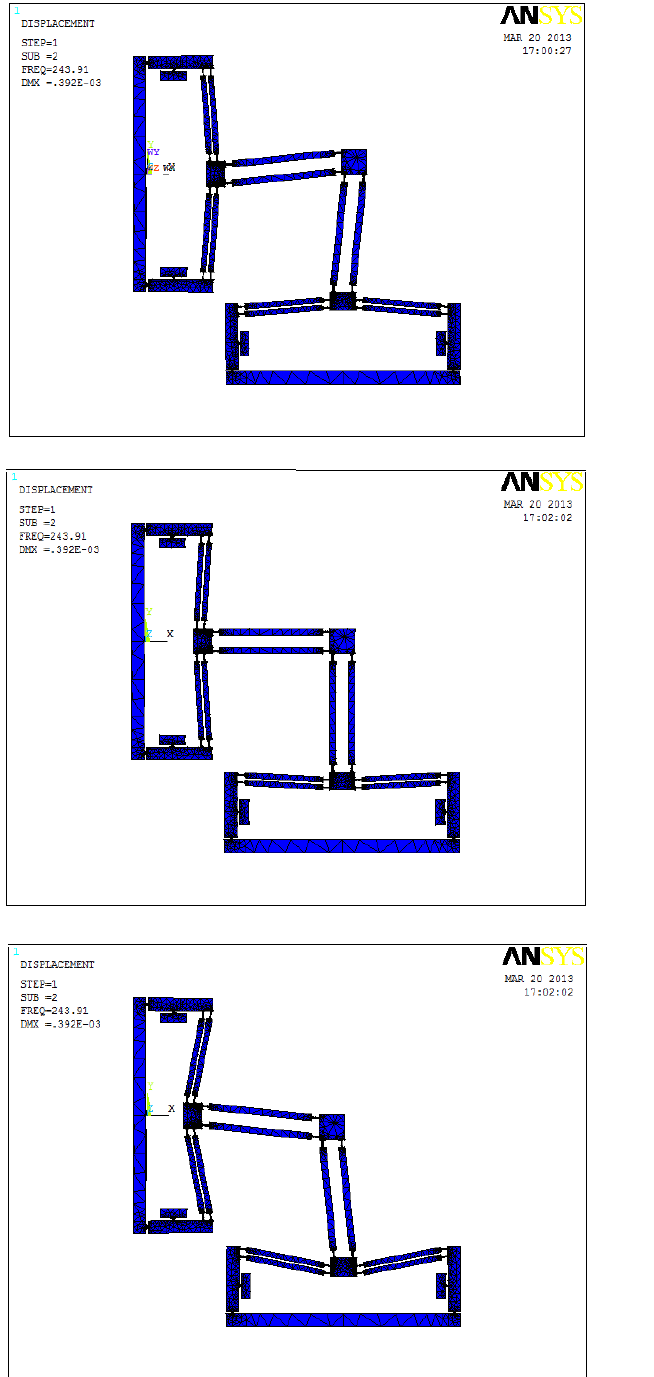
Fig. 7. Mode shape of the device corresponding to the first case Fig. 8. Mode shape of the device corresponding to the second case